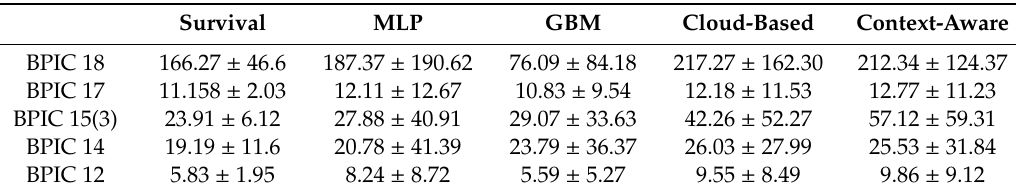
Table 3. Global Mean Average Error ± Standard Deviation.